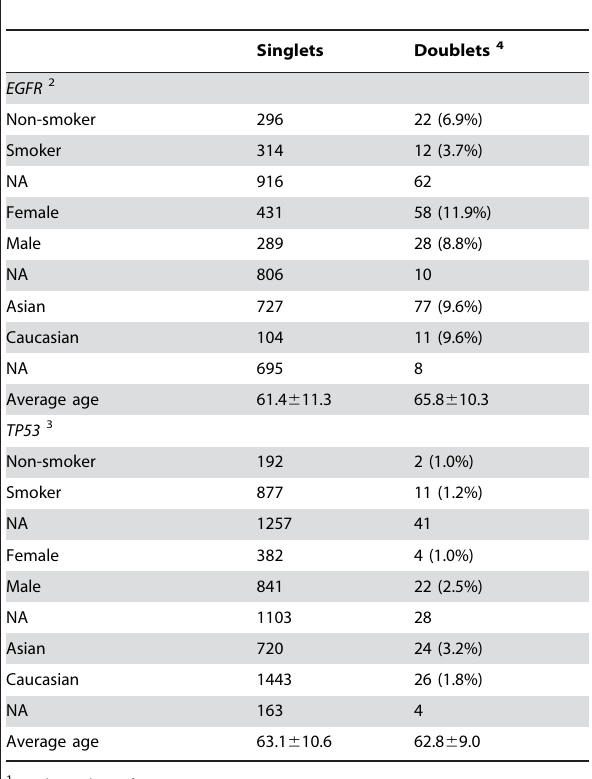
Table 1. The epidemiology of EGFR and TP53 doublets versus singlets 1 in lung